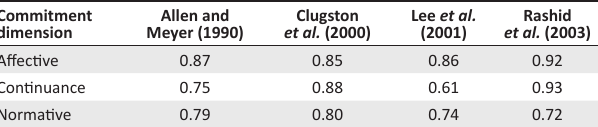
TABLE 1: The reliability of the Allen and Meyer (1990) OCQ